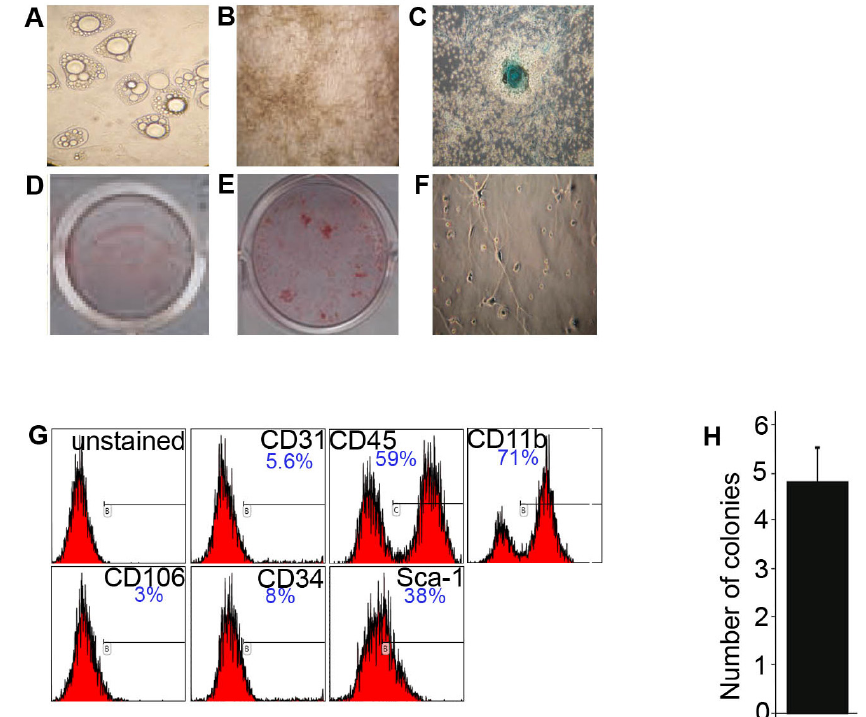
Figure 1. Characterization of BMSC. Upper panel : BMSC are capable of multilineage differentiation. Representative views of BMSC differentiated into adipocytes ( A ), osteocytes ( B ), chondrocytes ( C ) as confirmed by Alcian Blue ( C ), Oil Red O ( D ) and Alizarin Red S ( E ) staining; and into neuron-shaped cells ( F ). Lower panel : ( G ) CD profile of BMSC at day 7; ( H ) The amount of colonies detected in CFU-A per 10 5 of seeded